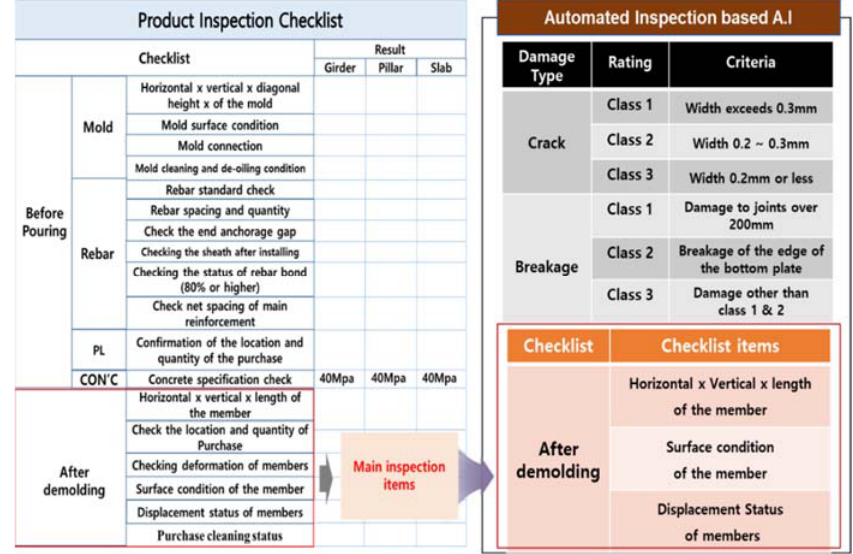
Figure 5. Classification of AI applicable major quality inspection items for PC members.